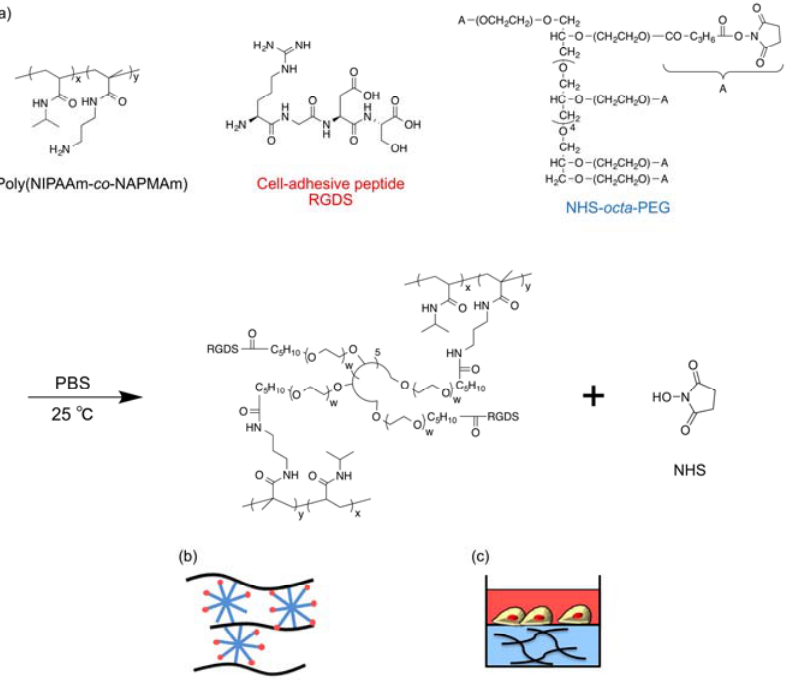
Figure 6. ( a ) Scheme for the gelation of the PNIPAAm gel. Schematic illustrations of ( b ) the molecular structure of the PNIPAAm gel and ( c ) the experimental set ‐ up for cell culture on the